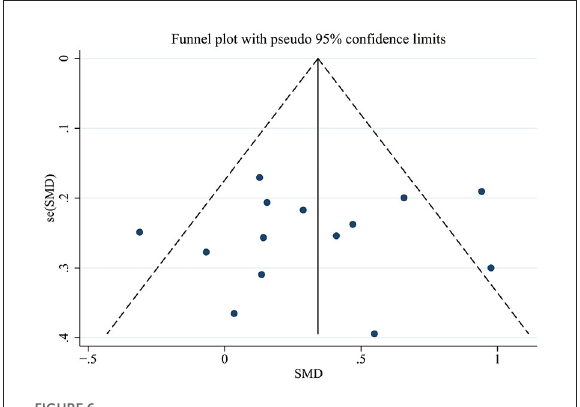
FIGURE6 Publication bias funnel plots of standard errors and effect sizes of the included studies.